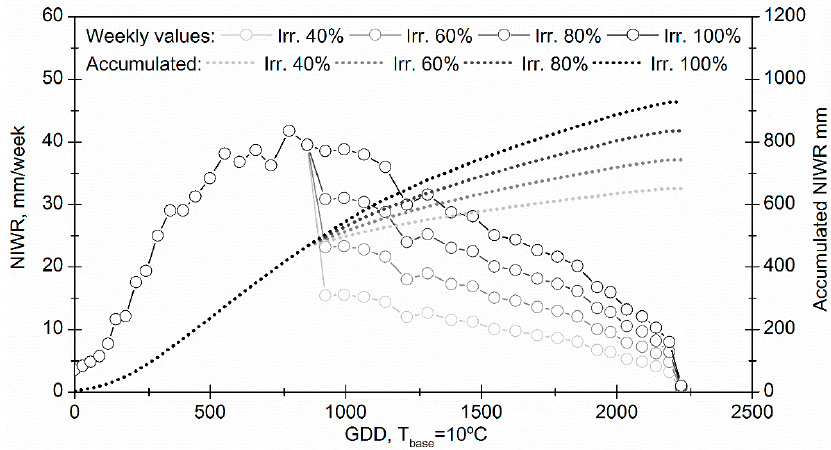
Figure 5. Temporal evolution of the net irrigation water requirements (NIWR) and seasonal accumulated values based on three strategies of deficit irrigation after harvest.